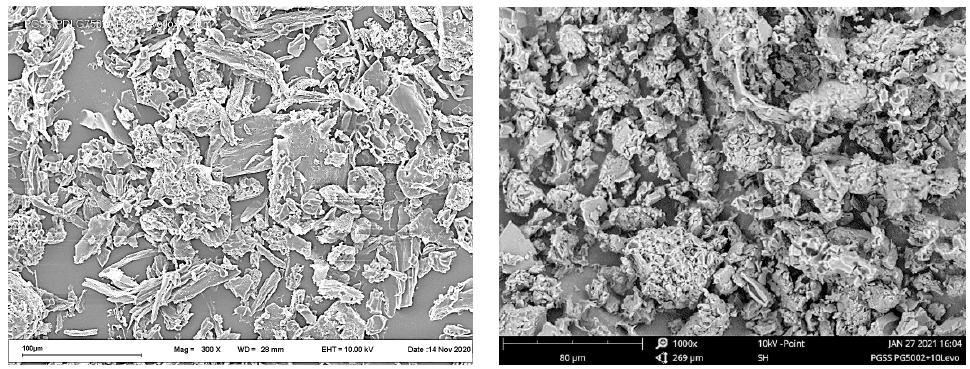
Figure 5. SEM images of PLGA/LFX microparticles produced by the PGSS technique using scCO 2 ( left ) and scCHF 3 ( right ).